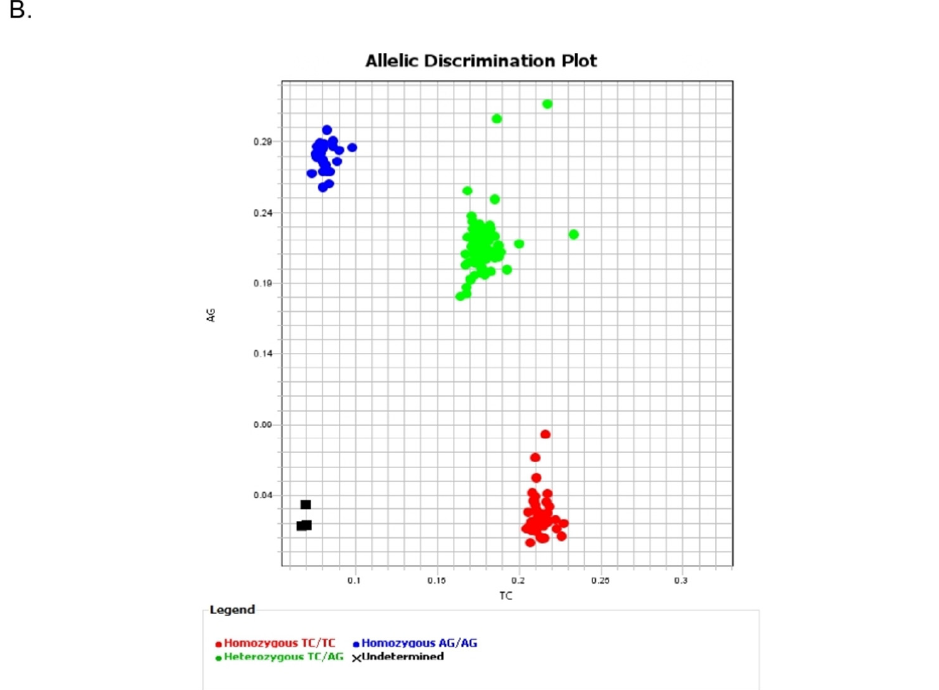
Figure 4. The xa5 -KASP marker’s development and validation. ( A ) Details on the locations of the selective KASP primers (FAM_primer and HEX_primer) and the common reverse primer. ( B ) Allelic discrimination plots of the PCR results of the xa5 -KASP markers genotyped in the F 2 population. Red dots represent the homozygous TC/TC genotype, blue dots represent the homozygous AG/AG genotype and green dots represent the heterozygous genotype. Table 5. Single-marker analysis of the xa5 -KASP marker on the 6 populations with Xoc isolate 2NY2-2. Cross